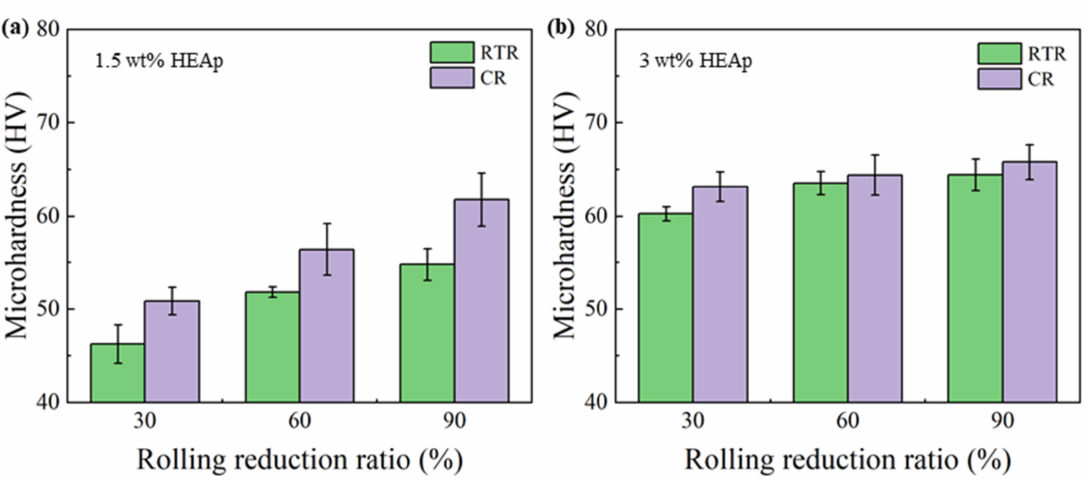
Figure 4. Microhardness of the AMCs after RTR and CR with ( a ) 1.5 wt% HEAp, ( b ) 3 wt%